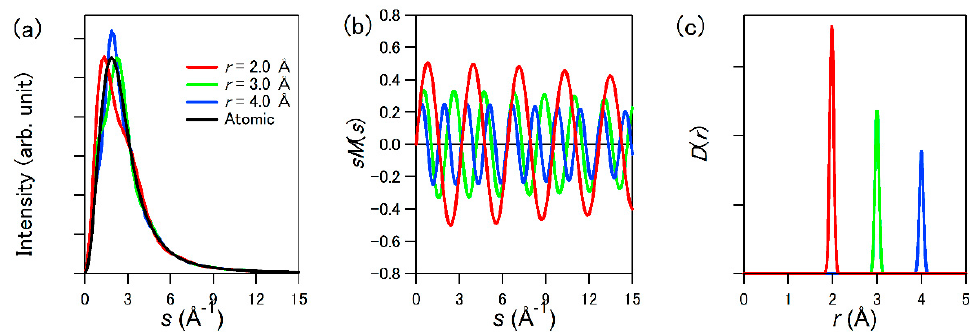
Figure 11. The model calculations of ( a ) scattering intensities, ( b ) sM ( s ), and ( c ) D ( r ) of the LAES by Cl 2 molecules with different internuclear distances; r = 2.0 Å (red solid line), 3.0 Å (green solid line), and 4.0 Å (blue solid line) for the n = +1 signal [9]. The mean amplitude was set to be l h = 0.044 Å. The black solid line in ( a ) represents the atomic scattering intensity of two Cl atoms. The kinetic energy of the incident electrons was 1 keV, and the laser-field parameters were Δ t = 200 fs, λ = 800 nm, and I = 1.8 × 10 12 W/cm 2 .